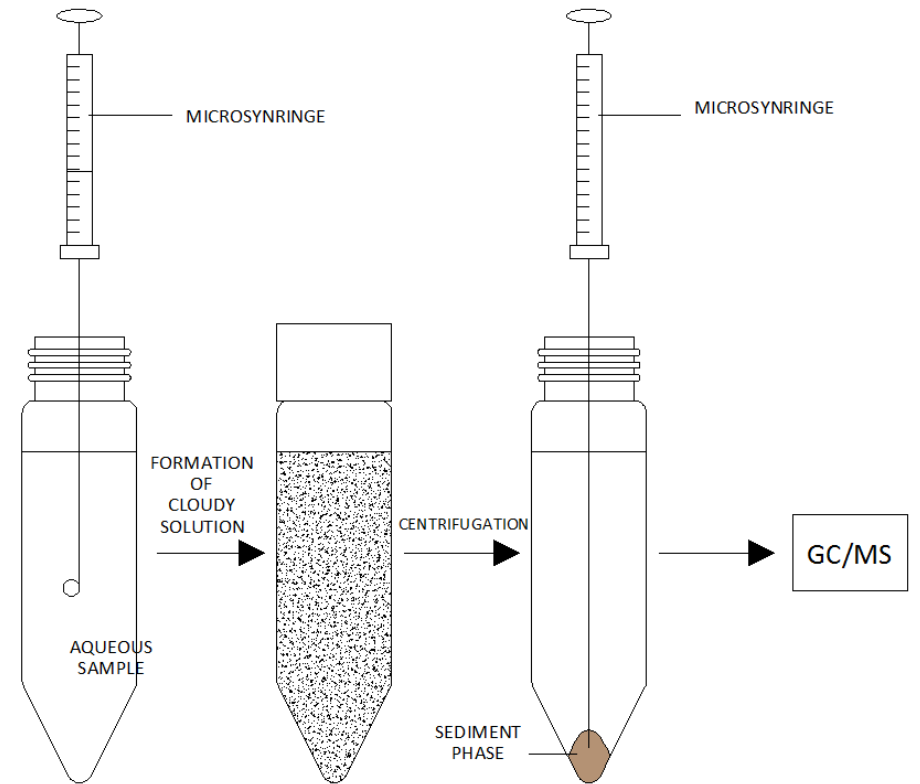
6. A diagram presenting consecutive stages of dispersive